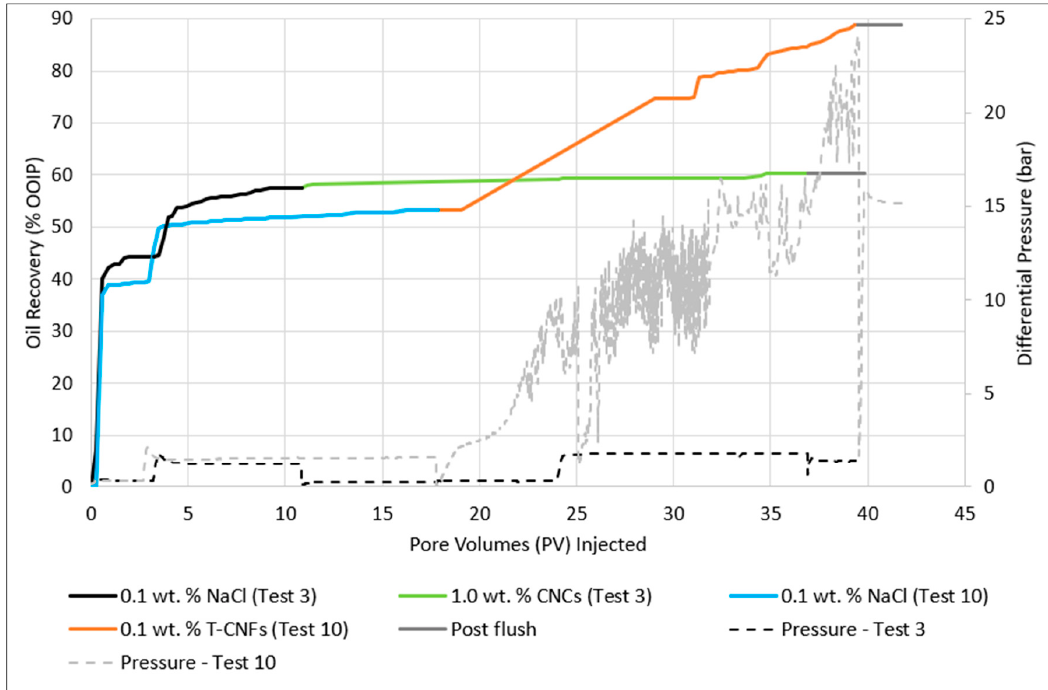
Figure 8. Recovery and corresponding pressure curves for 1.0 wt.% CNCs in 0.1 wt.% NaCl (Test 3) and 0.1 wt.% T-CNFs in 0.1 wt.% NaCl (Test 10).